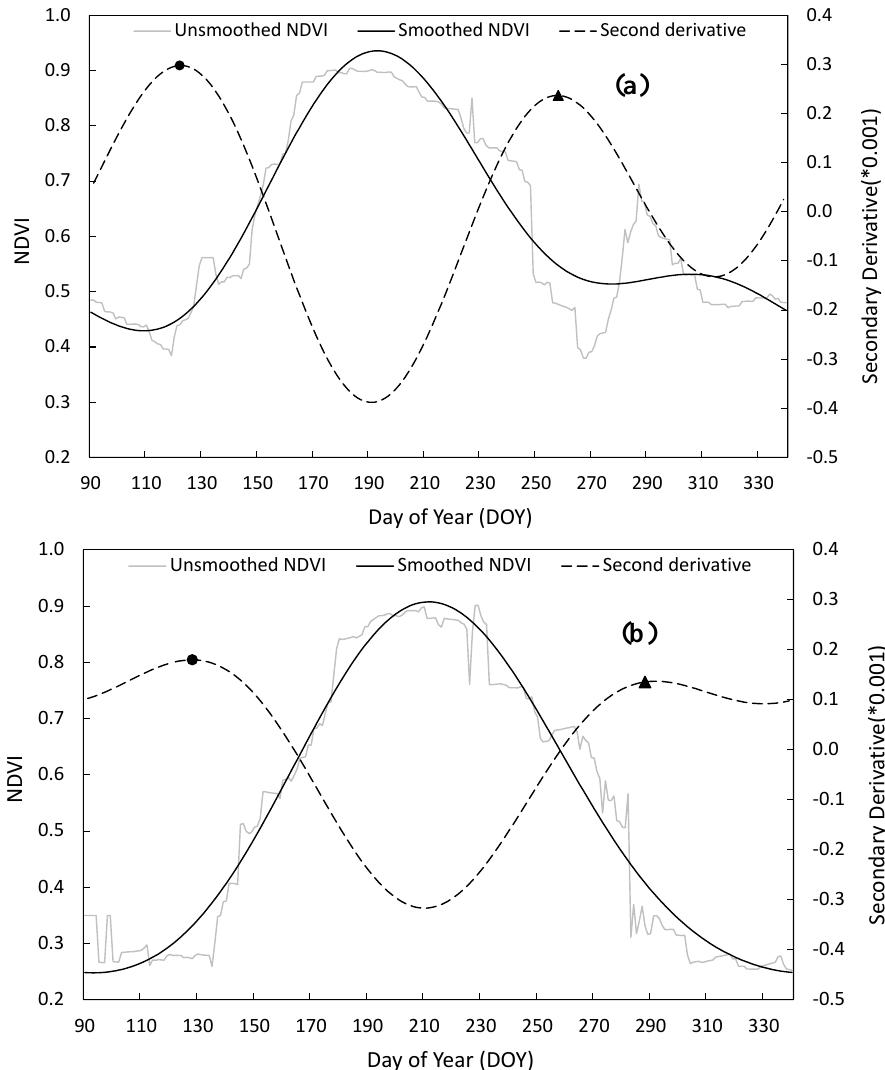
Figure 2. NDVI curves and second derivative of smoothed NDVI for ( a ) corn and ( b ) soybean with key points for planting and harvesting dates ( • Planting date, Second derivative peak; (cid:78) Harvesting date, Second derivative peak. Pure pixels were selected in the study area based on the CDL